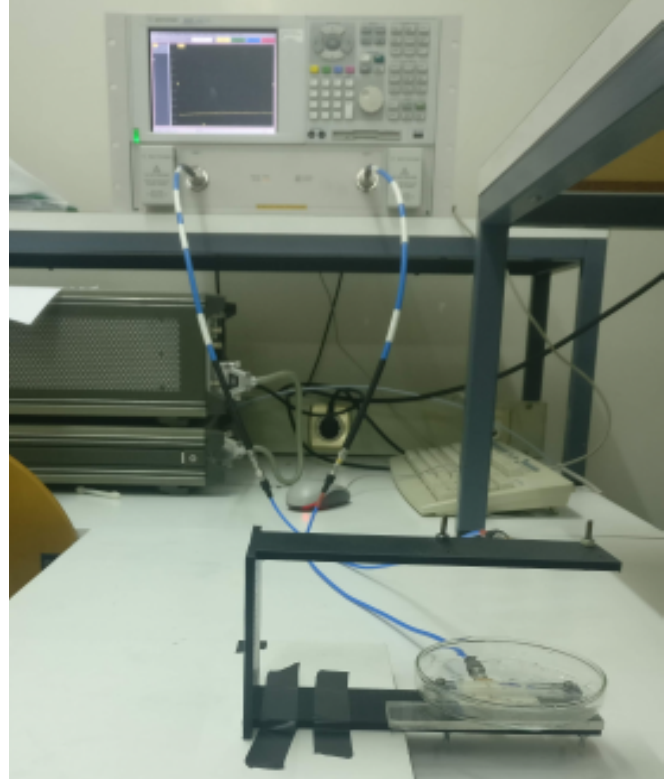
Figure 5. Previous Antennas setup to test sensibility to different amounts of water